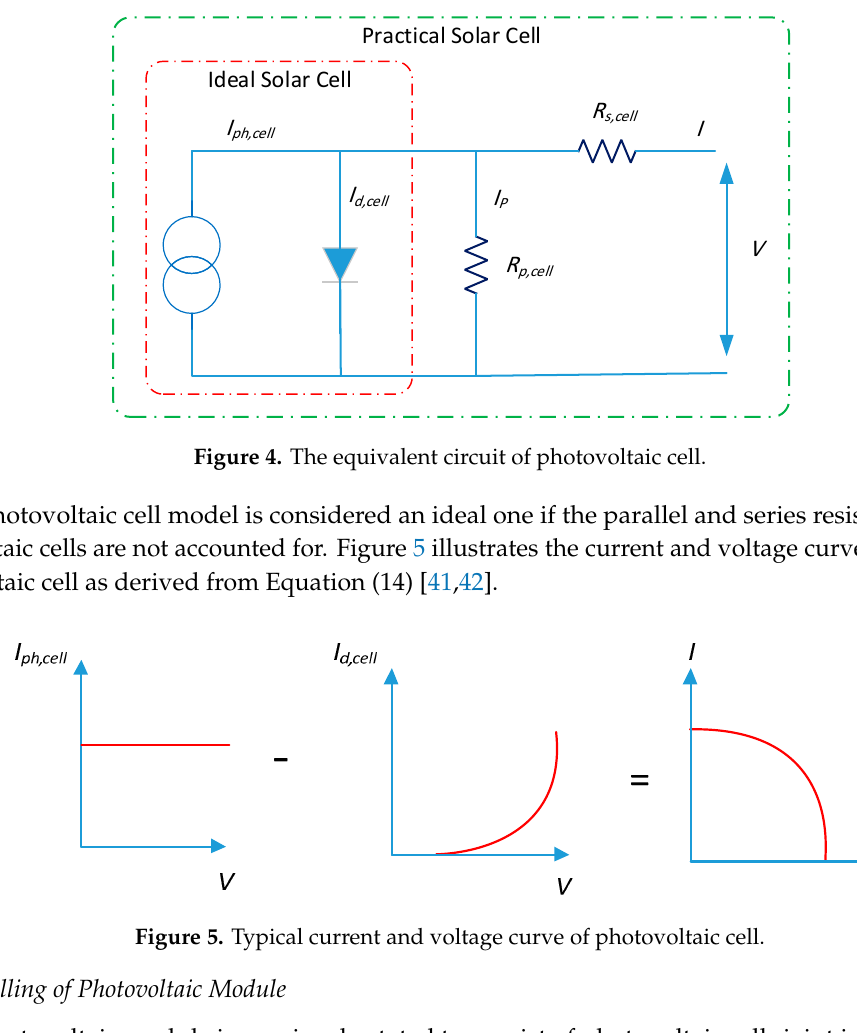
Figure 5. Typical current and voltage curve of photovoltaic cell.